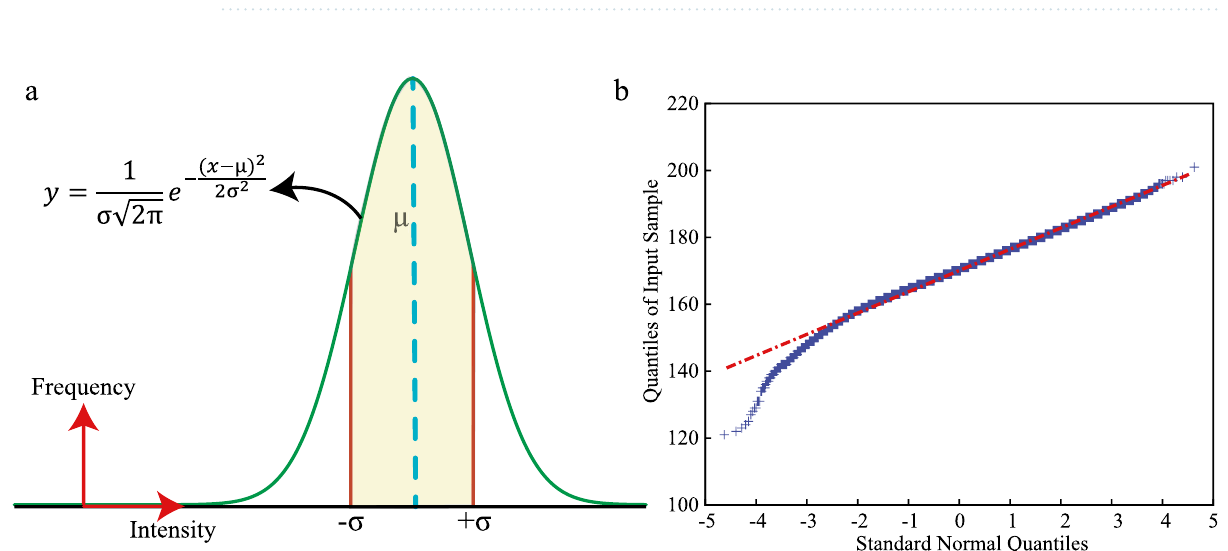
Figure 9. The graphical schematic of the statistical analysis is shown here. ( a ) The ± σ range under the Gaussian distribution curve is shown here. ( b ) Q–Q plot of a particular set of experiments is shown here to verify the normal distribution trend of the color intensity